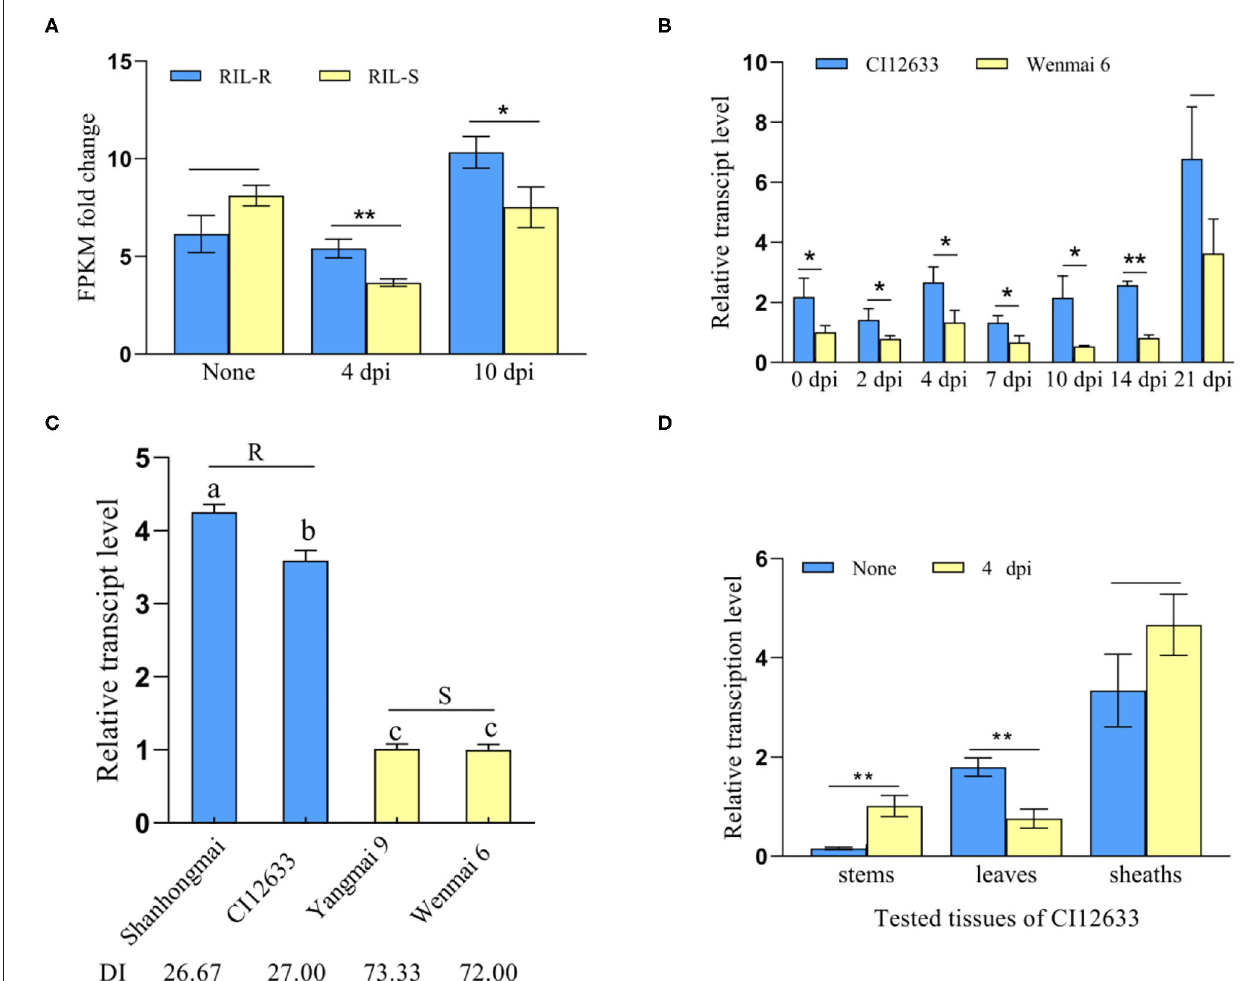
FIGURE 1 | TaWAK-6D was a response to Rhizoctonia cerealis . (A) The transcript pattern of TaWAK-6D in the RNA-sequencing (RNA-seq) data. The expression level of TaWAK-6D in the resistant recombinant inbred lines (RILs) (RIL-R) was higher than in the susceptible RIL (RIL-S) at 4 and 10 dpi with R. cerealis . No treatment means there was no R. cerealis inoculated on the seedings. Fragment per kilobase of exon model per million mapped reads (FPKM) was used to indicate the transcript level. (B) TaWAK-6D transcript in R. cerealis -resistant wheat line CI12633 and highly-susceptible wheat cultivar Wenmai 6 at 0, 2, 4, 7, 10, and 14 dpi with R. cerealis Rc207. TaWAK-6D transcript level at non-treatment was set to 1. (C) Transcript patterns of TaWAK-6D in four wheat cultivars at 4 dpi with R. cerealis . The disease index (DI) means the disease severity after inoculated with R. cerealis . The transcript level of TaWAK-6D in Wenmai 6 was set to 1. (D) Transcript pattern